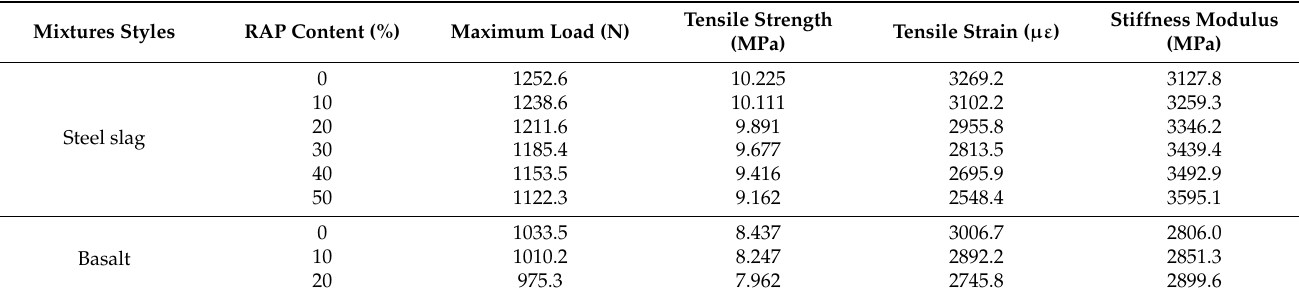
Table 3. The crack resistance indexes of